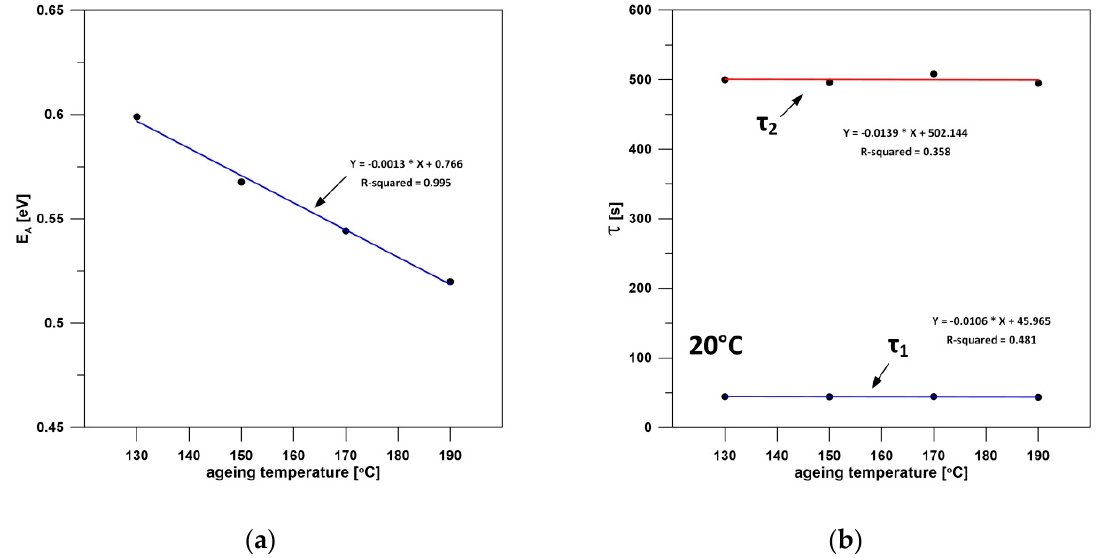
Figure 13. Dependence of the E A activation energy ( a ) and dominant time constants τ 1 and τ 2 ( b ) on the degree of ageing for unmoistened cellulose–aramid insulation samples.